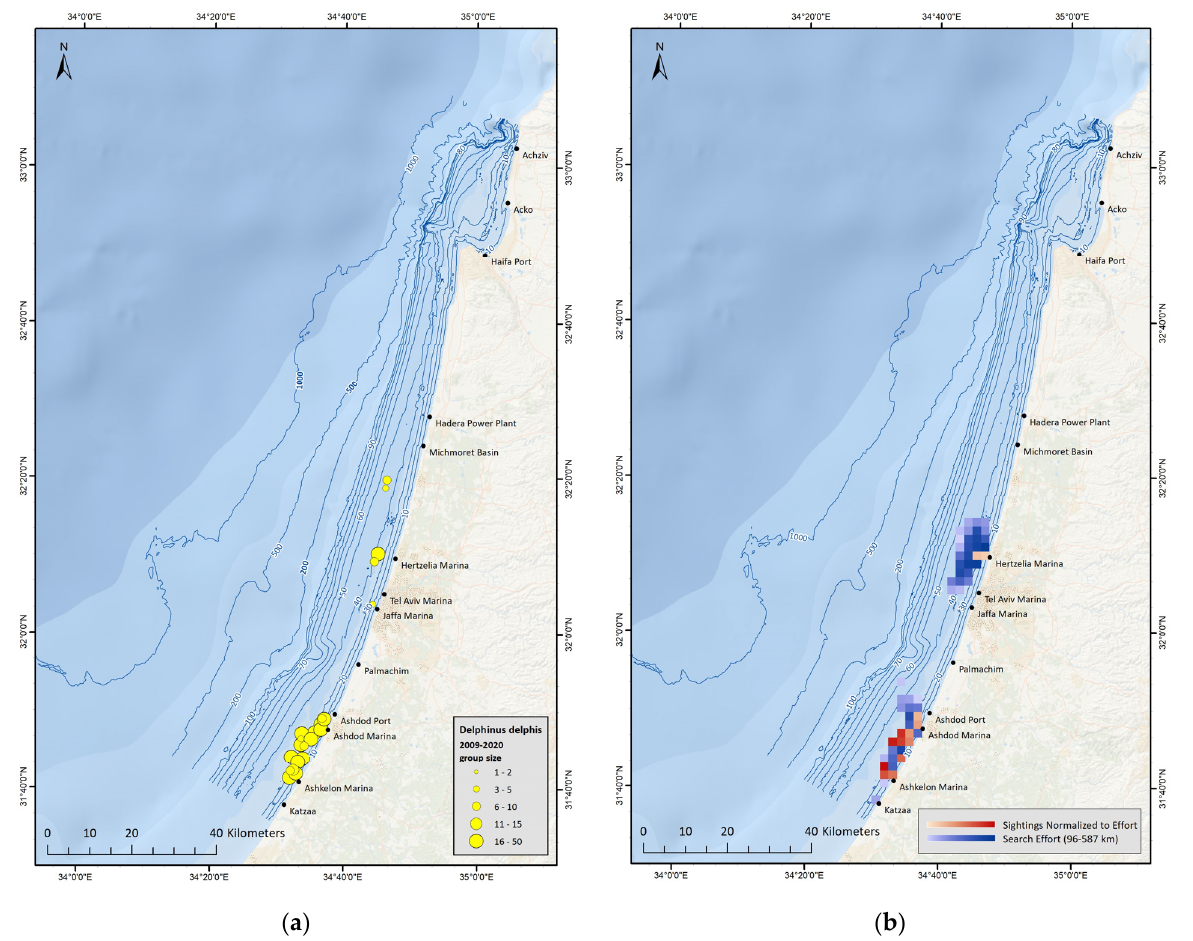
Figure 3. ( a ) Map displaying all sightings from surveys along the Israeli Mediterranean coast between 1999 − 2020, with the yellow circles representing D. delphis sightings; ( b ) Map of study area, displaying survey effort and D. delphis sightings (normalized to survey effort), presenting only grid-cells with sufficient survey effort to surpass the correlation threshold, during the years 2010 − 2019.